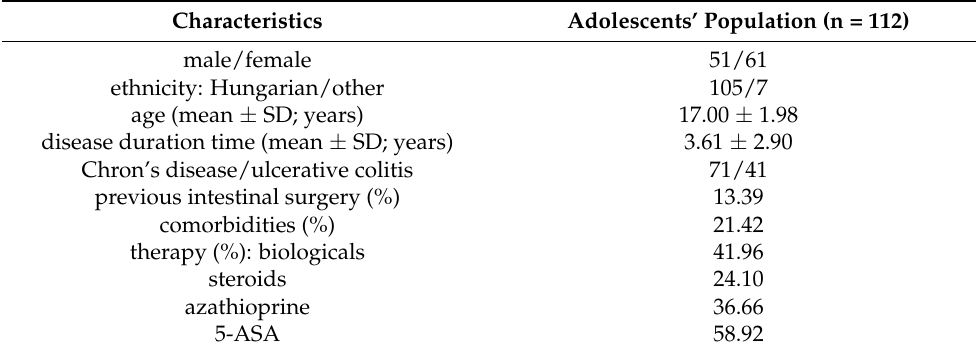
Table 1. The main characteristics of patients involved. Characteristics Adolescents’ Population (n = 112) male/female 51/61 ethnicity: Hungarian/other 105/7 age (mean ± SD; years) 17.00 ± 1.98 disease duration time (mean ± SD; years) 3.61 ± 2.90 Chron’s disease/ulcerative colitis 71/41 previous intestinal surgery (%) 13.39 comorbidities (%) 21.42 therapy (%): biologicals 41.96 steroids 24.10 azathioprine 36.66 5-ASA